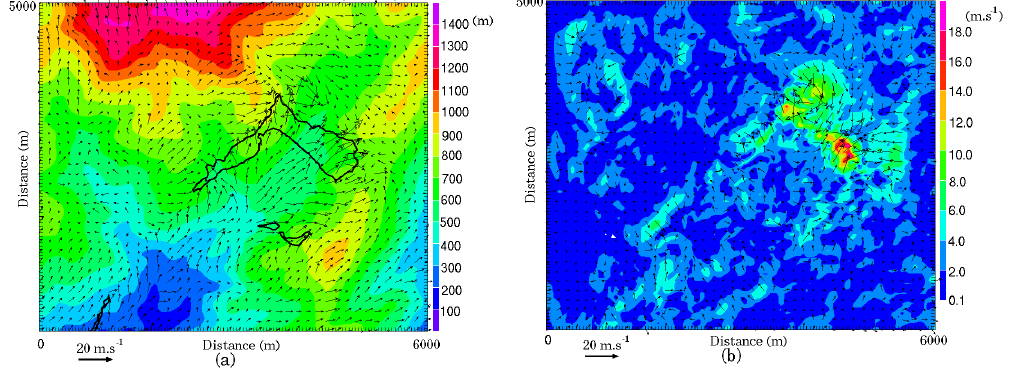
Figure 15. “Fire-to-atm” simulation on 23 July 2009 at 1500 UTC: horizontal cross-sections of ( a ) the fire front (in black) at the ground superimposed on the wind vectors (arrows) and on the orography (color, in m); ( b ) the difference between “fire-to-atm” and “uncoupled” simulations of 10-m wind intensity with wind vectors superimposed (in ms − 1